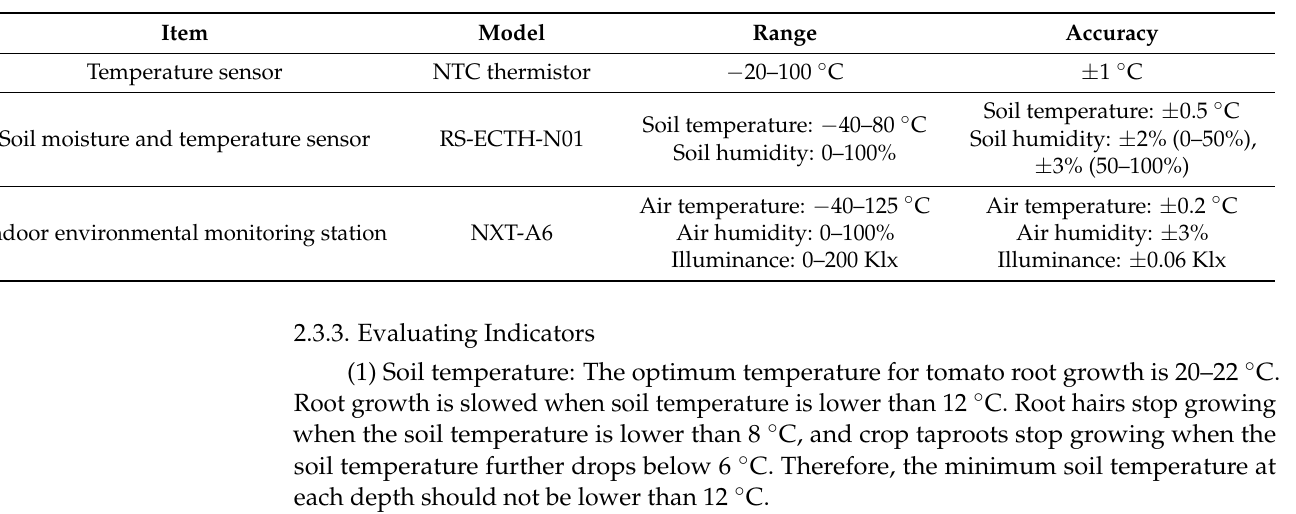
Figure 10. The cloud platform for the field experimental system.